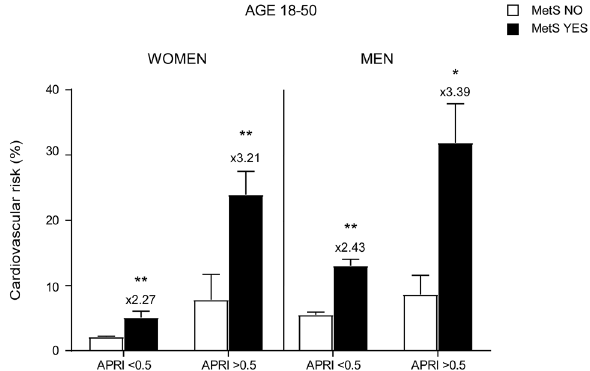
Figure 7. Characterization of cardiovascular risk in adults age 18–50 based on gender and APRI score levels. T-Test analysis of CVR in females and males age 18–50. Subjects were divided based on MetS diagnosis and APRI levels. Data is presented as mean ± SEM. Statistical significance was assessed by Student T-test (*p < 0.05, **p < 0.01). Multipliers are shown to identify difference in CVR in males compared to